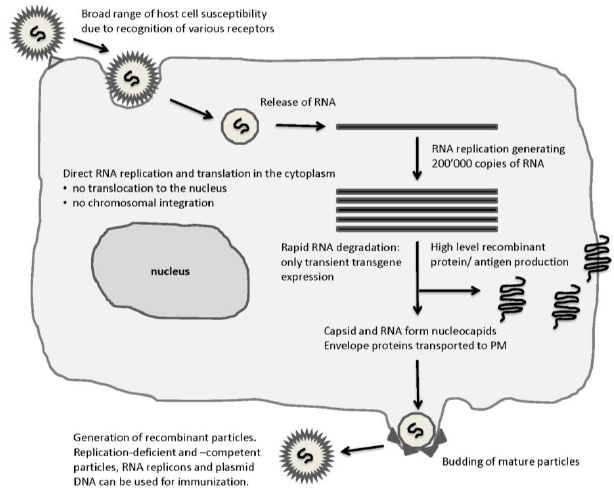
Figure 5. Schematic Presentation of the Life-Cycle of Self-Replicating RNA Viruses and Their Advantages. Several cell receptors are recognized providing a broad range of susceptible host cells. RNA released in the cytoplasm is immediately subjected to RNA replication and translation. Extreme RNA replication is the basis for highly efficient transgene expression. Table 4. Comparison of Self-replicating RNA Viral Vectors with other Viral Vectors.